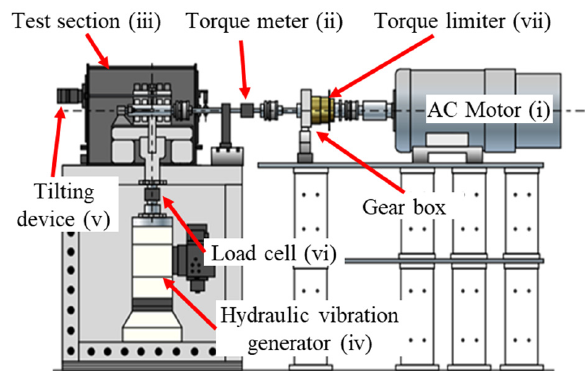
Figure 1. Configuration of bearing tester.